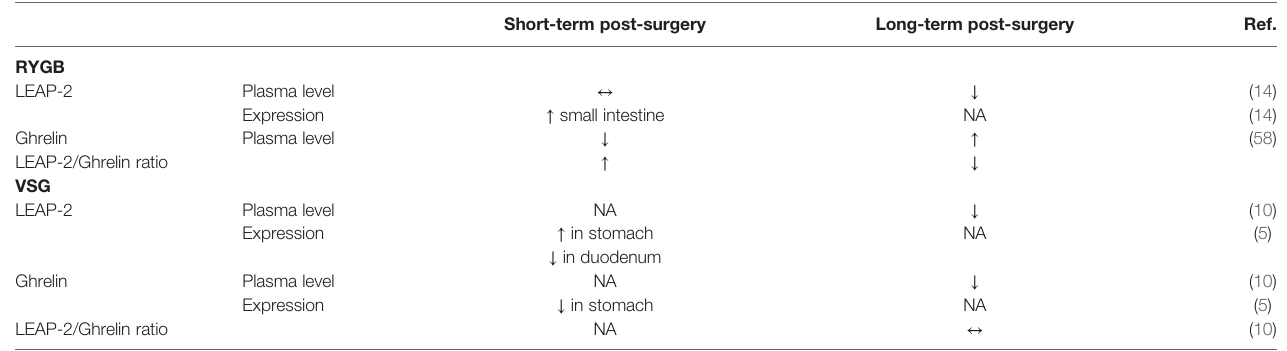
TABLE 4 | Changes in circulating and expression levels of LEAP-2 and ghrelin post bariatric surgeries. Short-term post-surgery Long-term post-surgery